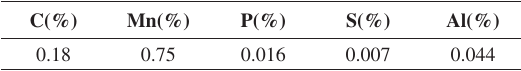
Table 1. Measured chemical properties of steel